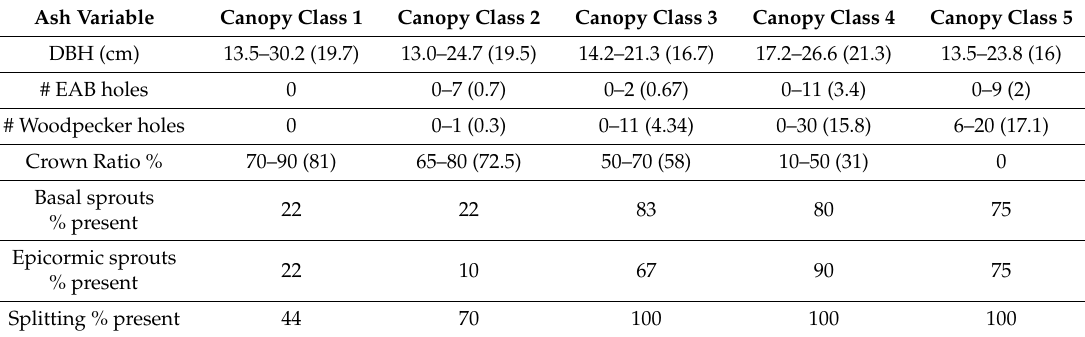
Table 2. Measured variables for focal ash trees in five canopy health classes, range of values are given as well as average in parentheses for DBH, number of EAB and woodpecker holes, and crown ratio (%). Basal sprouts, epicromic sprouts, and splitting were presence/absence data; therefore, percent of trees with the variable present is